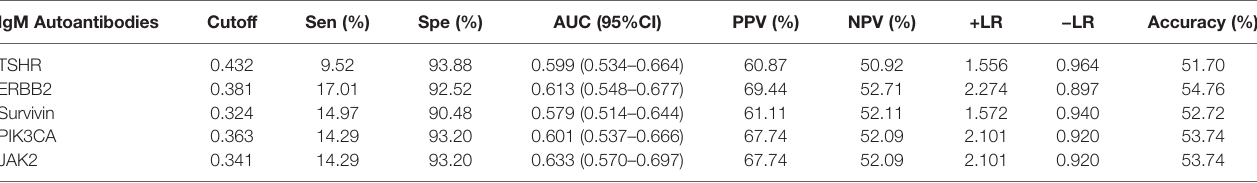
TABLE 2 | Diagnostic value of fi ve IgM autoantibodies in the validation cohort for the detection of lung adenocarcinoma (LUAD).